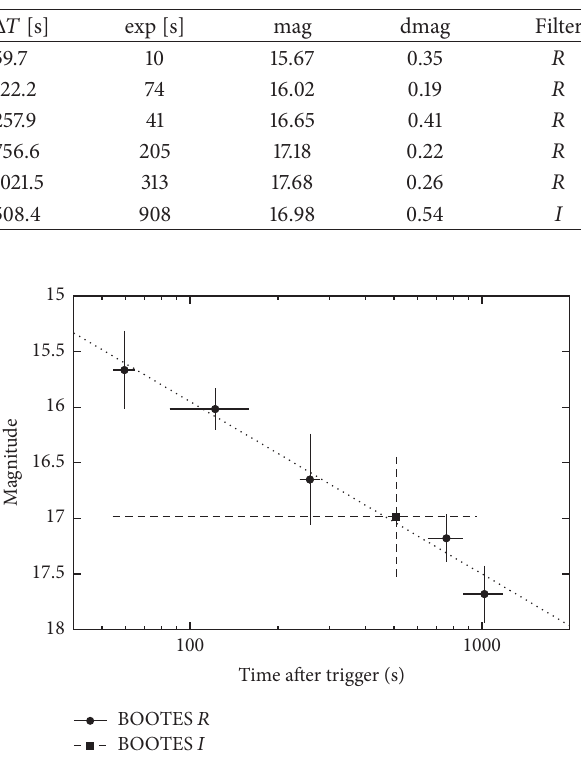
Figure 2: The optical light curve of GRB 051109A. The dotted line represents the optical decay observed by Mirabal et al.